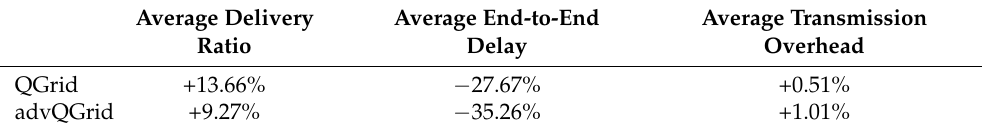
Figure 16. Simulation comparison among different routing protocols vs. different numPairs. Table 11. Performance improvement of SD-QGrid compared to routing protocols with numPairs.